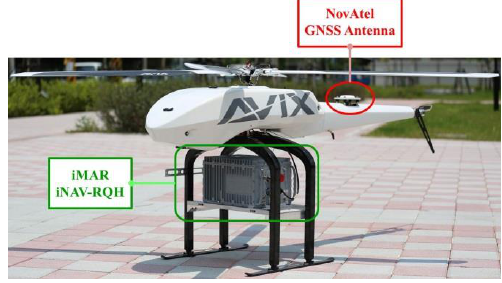
Figure 2. The configuration of INS and GNSS